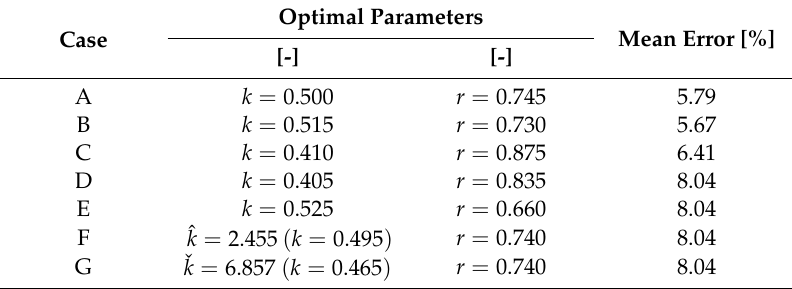
Table 4. Mean errors for cases A–G; values of k and r obtained from the optimization process.